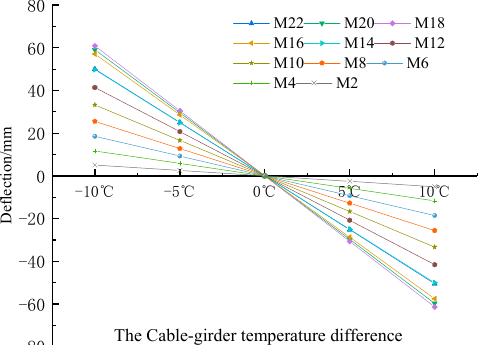
Figure 18. The de fl ection curve at di ff erent positions of the girder varying with cable–girder tem- perature di ff erence.